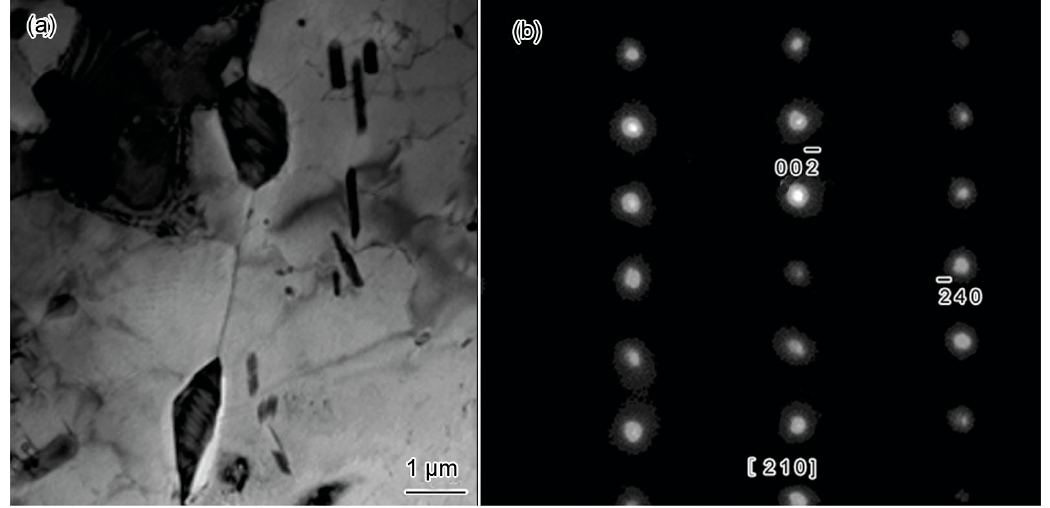
Figure 6. ( a ) Micrographs of particles at the grain boundary and ( b ) SAED pattern.